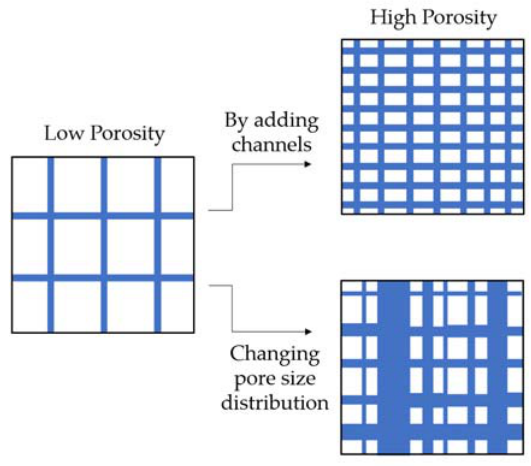
Figure 2. Different throat size distributions with same porosity but different mean throat diameter and standard deviation of the throat size. Solid in white and liquid saturated void space (i.e. pores and throats) in blue.